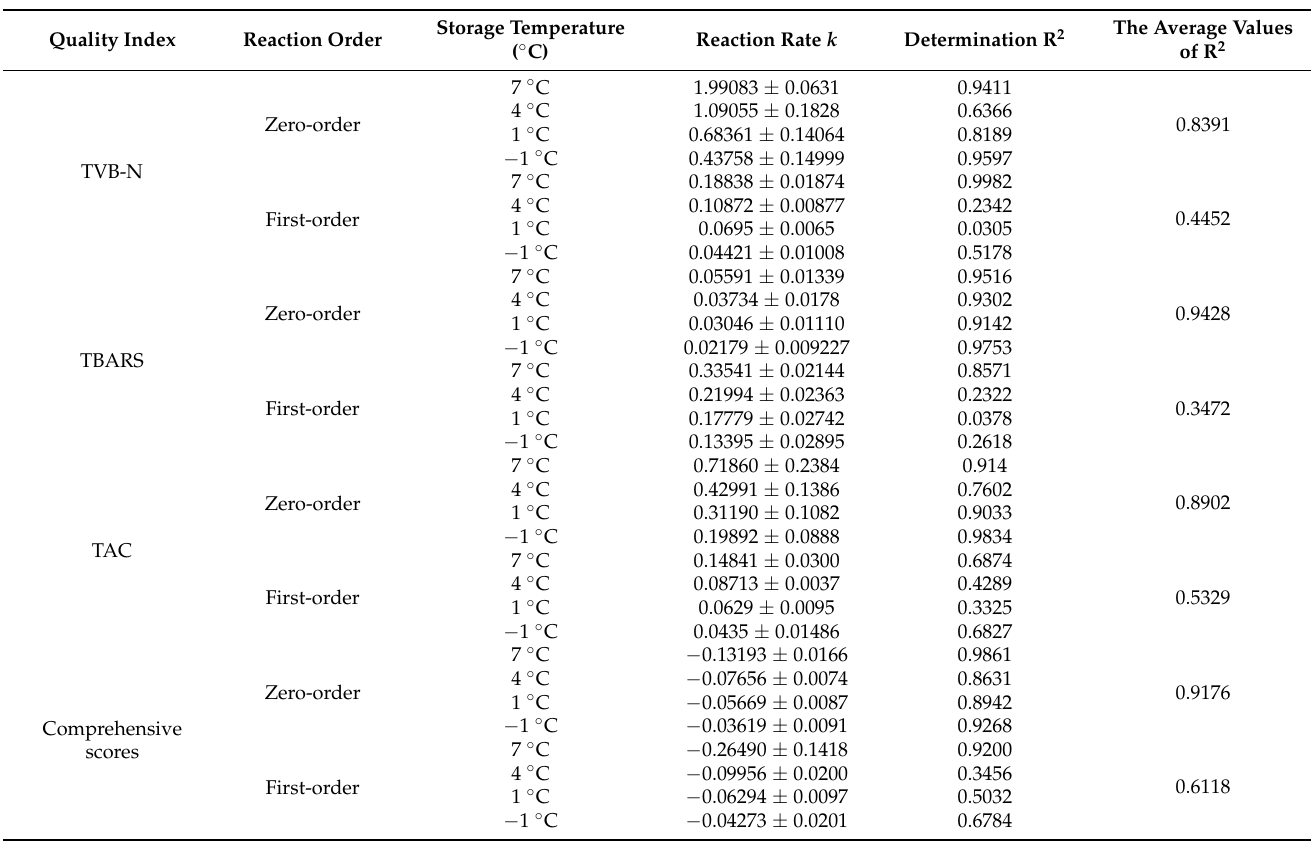
Table 2. Zero- and first-order kinetic reaction rate constants k and coefficient of determination R 2